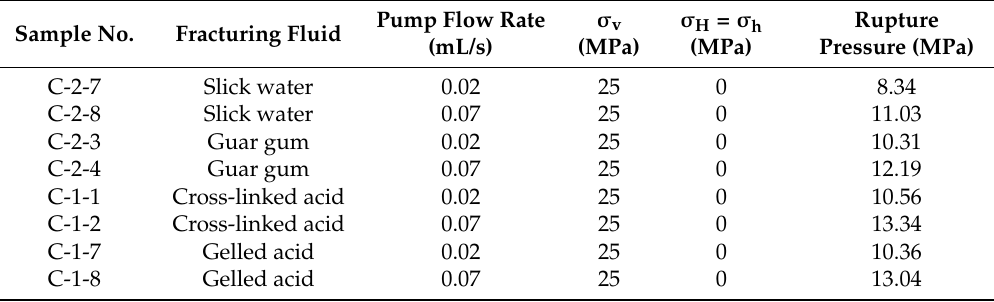
Table 2. Overview of the fracturing test